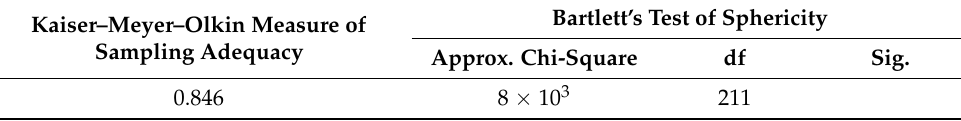
Table 1. Correlation between data, for which the Bartlett 7 test ought to be applied.